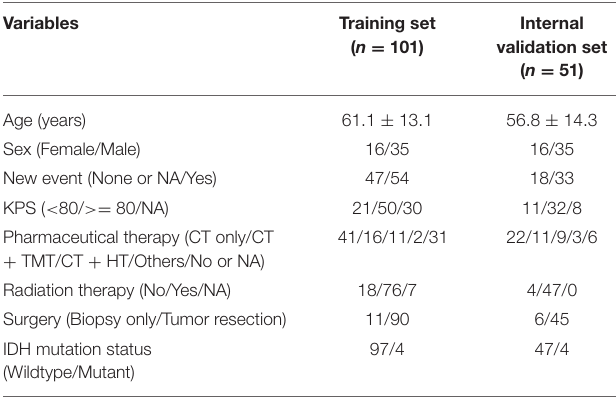
TABLE 1 | Demographics and clinical characteristics of the TCGA GBM patients in the training cohort ( n = 101) and internal validation cohort ( n = 51).